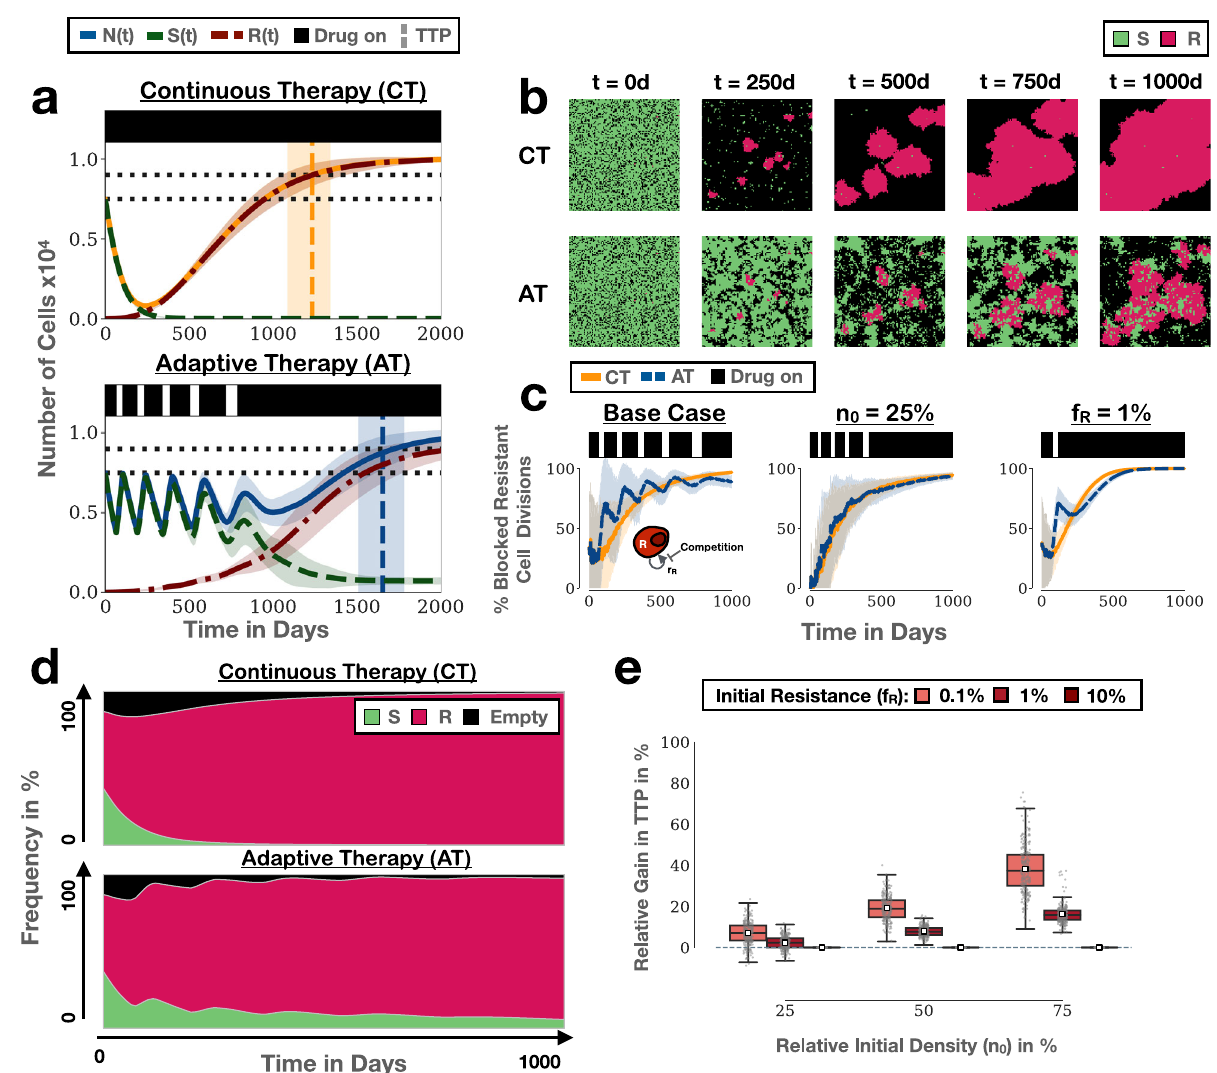
Fig. 2 Adaptive therapy prolongs TTP by leveraging inter- and intra-tumoral competition. AT: adaptive therapy, CT: continuous therapy, TTP: time to progression, ABM: agent-based model. a Example simulations of the treatment dynamics under continuous and adaptive therapy in our ABM (( n 0 , f R ) = (75%, 0.1%)). Shown are the mean and standard deviation (shading) of the tumour cell number (sensitive, resistant and total; n = 250 independent replicates). Black bars represent a typical treatment schedule (see also Supplementary Fig. 4). Horizontal dotted lines show the initial cell number and the cell number at progression, respectively. Vertical lines and associated shading mark the mean, and the 1st and 3rd quartile of the distribution of TTP. b Snapshots from one of the replicates in a illustrating how adaptive therapy delays competitive release of resistance. c Adaptive therapy (blue line) results in a higher proportion of blocked resistant cell divisions than continuous therapy (yellow line) in the initial stages of treatment in the simulations in a (left panel). However, the ability of adaptive therapy to induce blocking depends on the initial tumour cell density (centre panel; ( n 0 , f R ) = (25%, 0.1%)) and the initial resistance fraction (right panel; ( n f R ) = (75%, 1%)). Lines and shading indicate mean and standard deviation, respectively. 0 , d Average frequency of sensitive cells, resistant cells, or empty space in a resistant cell ’ s neighbourhood in the simulations in a . This shows that there is not only inter-, but also signi fi cant, intra-speci fi c competition during adaptive therapy. Values are the mean in the von Neumann neighbourhood across all resistant cells from 250 independent simulations. e Gain in TTP achieved by adaptive therapy relative to continuous therapy as a function of n 0 and f R ( n = 1000 independent replicates per condition). Adaptive therapy yields the greatest bene fi t when tumours are close to their carrying capacity and resistance is rare. The box, centre line, small white squares, and whiskers denote the inter-quartile range, median, mean, and 1.5x inter-quartile range, respectively. Negative values denote cases in which continuous therapy achieves a longer TTP. Resistance costs and turnover are assumed to be 0 throughout this fi